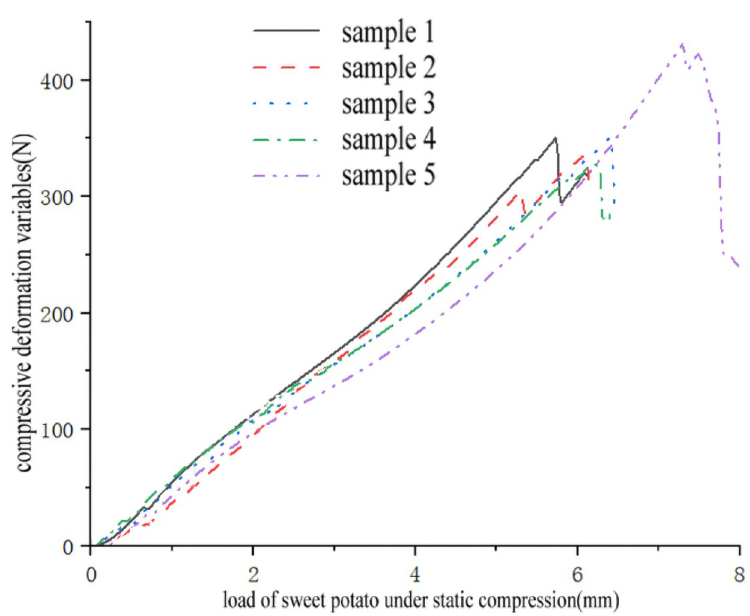
Fig 4. Relationship between compressive deformation variables and load of sweet potato under static compression. Data curve of sweet potato firmness